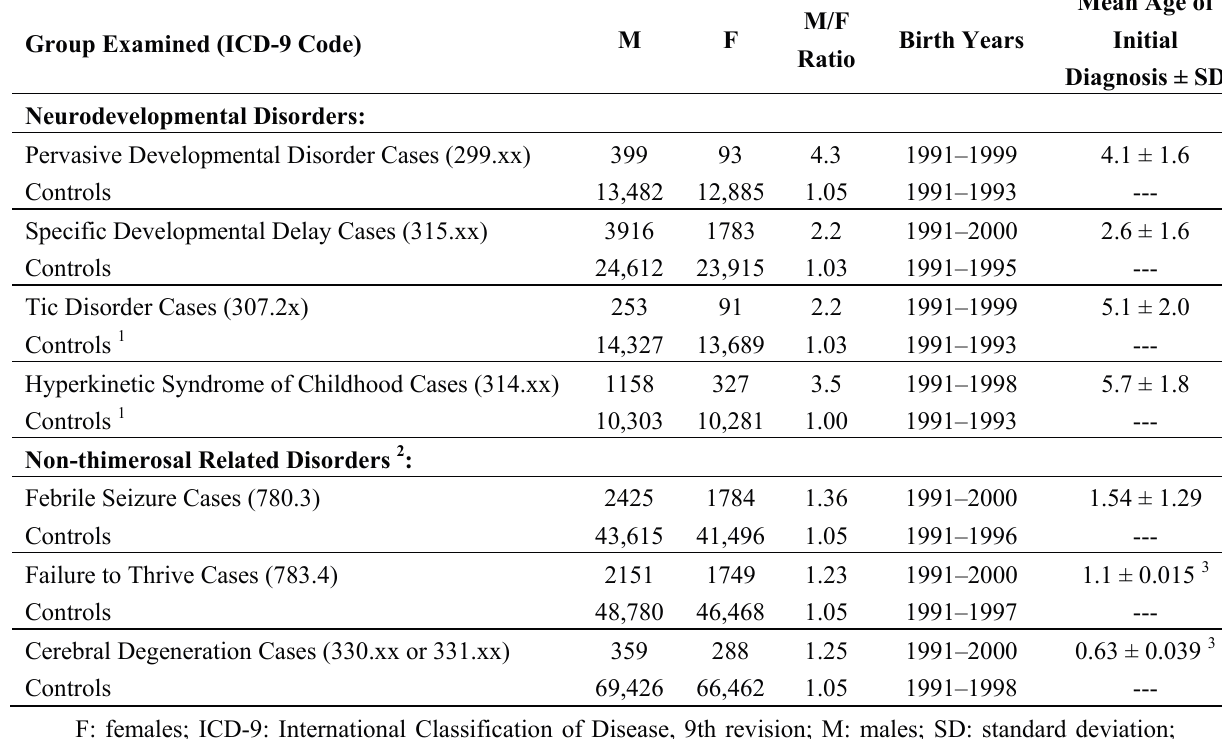
Table 1. A summary of various types of cases and controls examined in the present